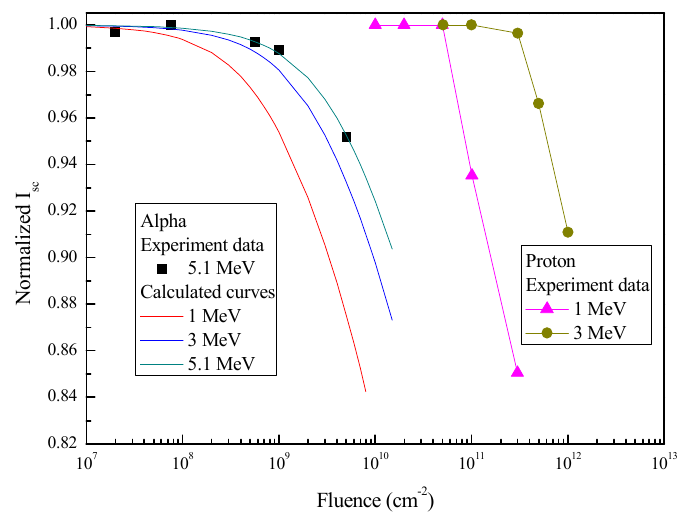
Figure 6. Normalized I sc of the InGaP/GaAs/Ge solar cells as a function of the fluence for various alpha-particle and proton energies. Materials 2018 , 11 , x FOR PEER REVIEW